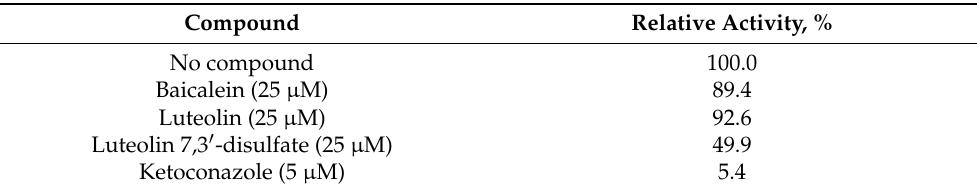
Table 2. Effect of compounds on catalytic activity of human CYP51A1 (lanosterol 14 α -demethylase) in the reconstituted system in vitro.